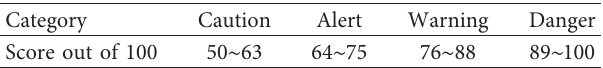
Table 2: Road hazard